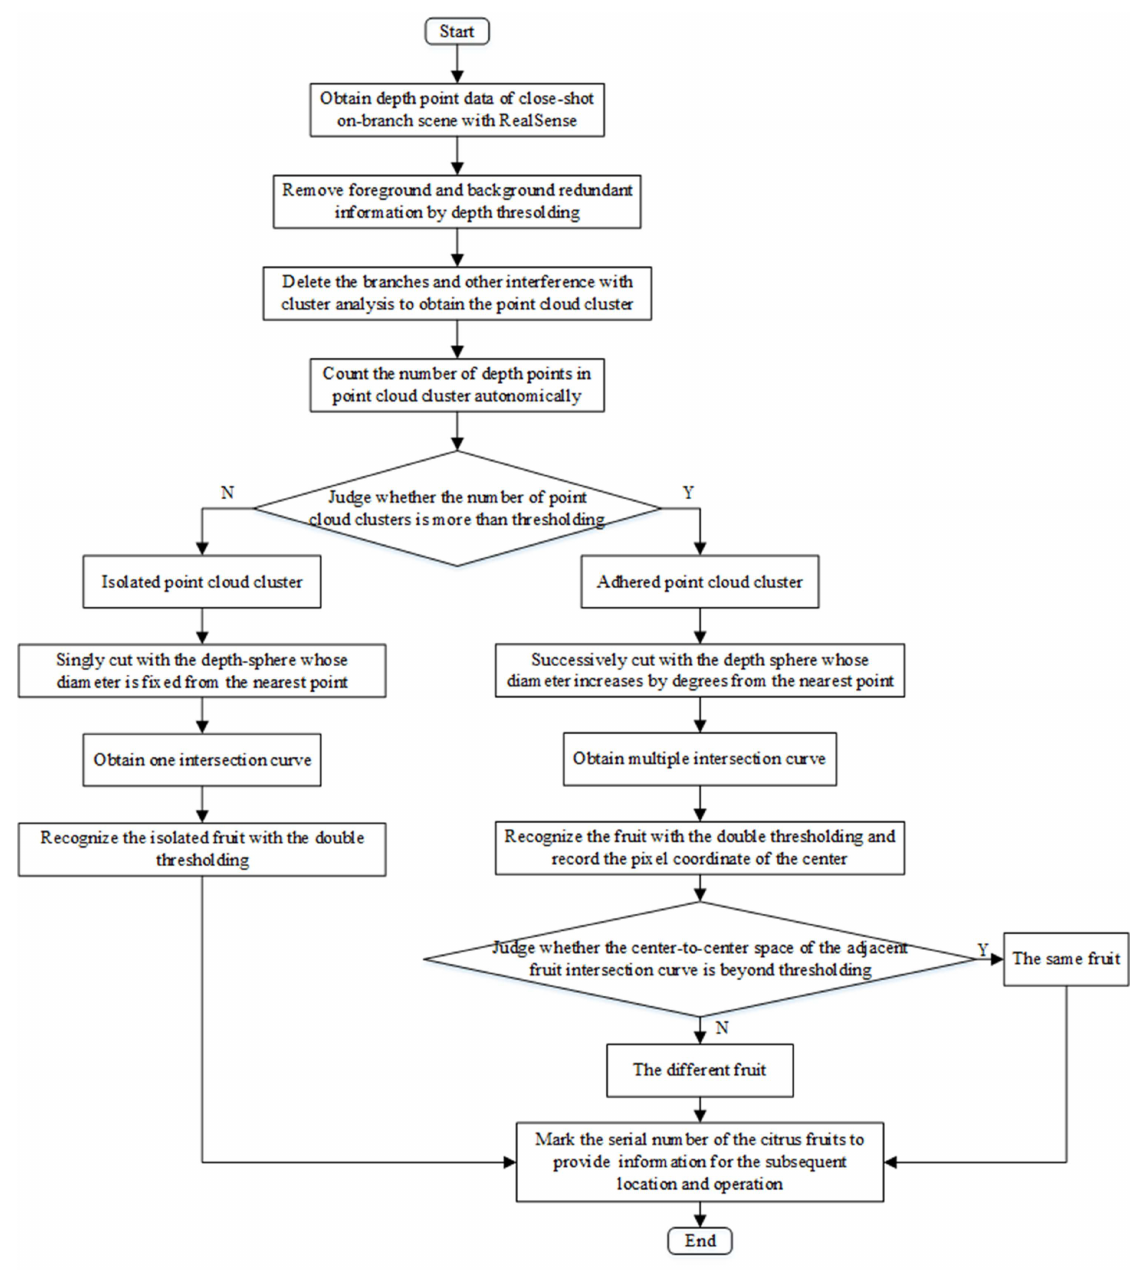
Figure 8. Flowchart of fruit recognition in the complex on-branch